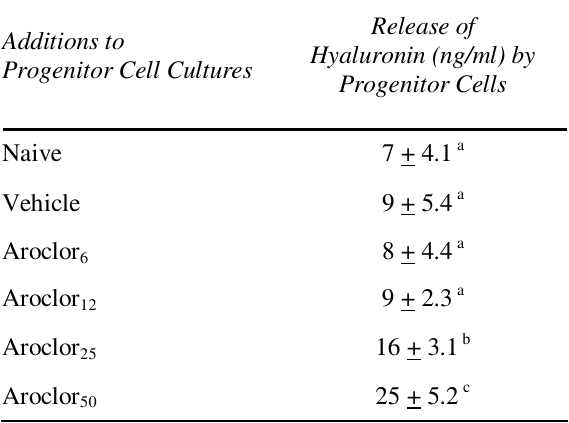
Table 2: Cytotoxicity of Aroclor on Progenitor Cell Cultures: Isolated PC (5 X 10 6 cells/mL) was incubated or vehicle for 24 hrs. After with Aroclor (6, 12, 25 or 50 µM) this incubation, PC was washed and the analysis of hyaluronan release was used as the endpoint for the = PCB determination of cytotoxicity. Aroclor (X) mixture, Aroclor, where (X) is the concentration of Aroclor; Values represent mean + S.E.M.; where either a, b or c indicate values that are significantly (p<0.05) different from each other.